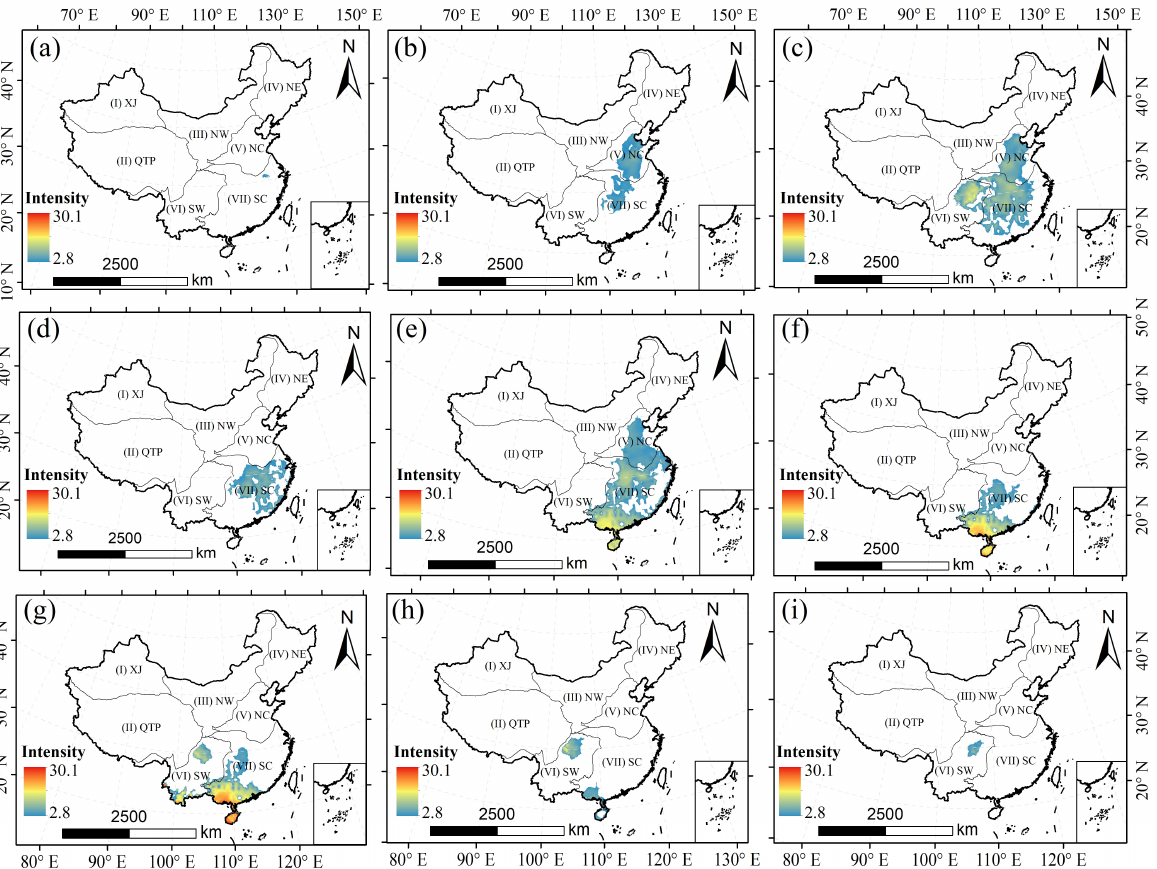
Figure 16. The temporal and spatial evolution process of the heatwave event with the longest dura- tion. ( a – i ) represent the distribution of heatwave events on 12 July, 16 July, 21 July, 31 July, 10 Au- gust, 20 August, 25 August, 30 August, and 5 September of 2018,